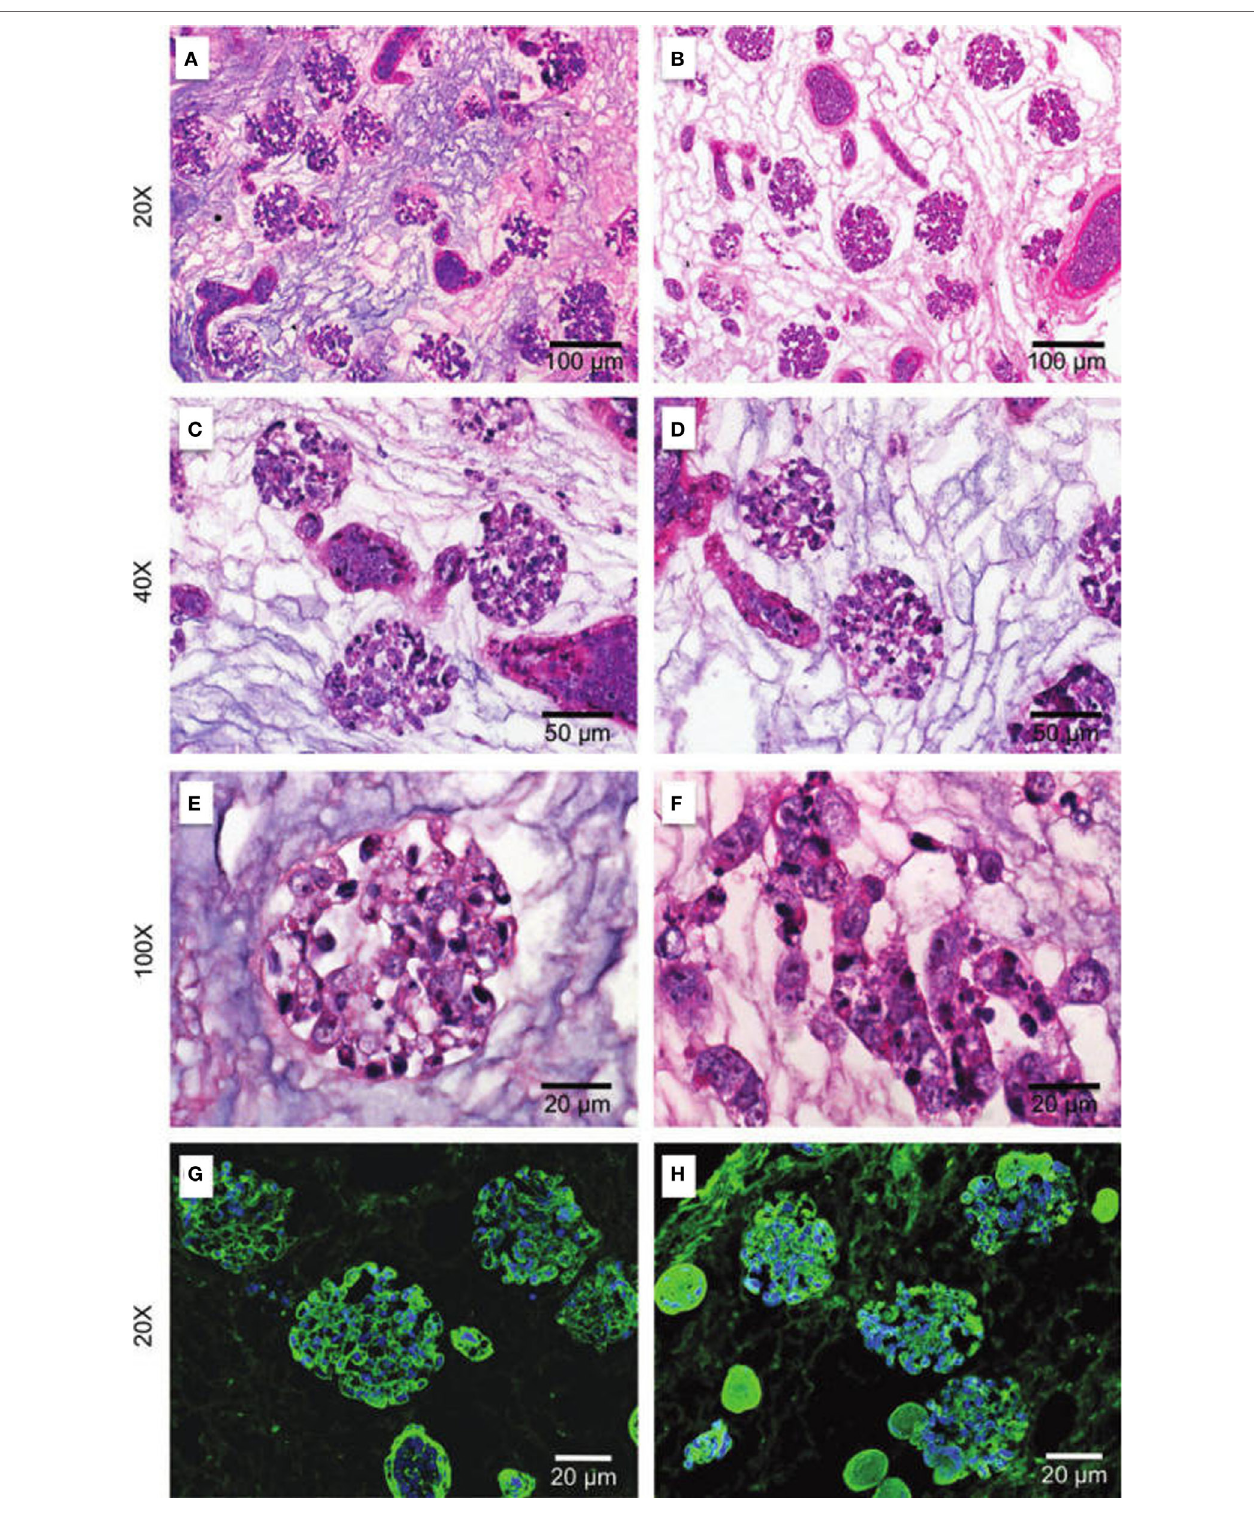
FiGURe 3 | Repopulation of kidney scaffolds with meS cells . Hematoxylin and eosin staining at 24 h (A,C,e) and 72 h (B,D,F) and immunostaining for WGA agglutinin and DAPI at 24 h (G) and 72 h (H) in kidney scaffolds seeded with mES cells show a homogeneous distribution of cells into glomerular and vascular structures, peritubular capillaries, and tubules. mES, murine embryonic stem cells. Reprinted and modified with permission from Bonandrini et al. (2014).